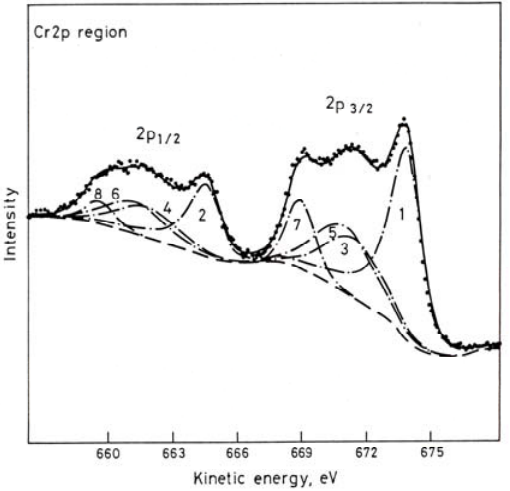
Figure 4. Mg K α -excited spectrum of the Cr 2p region of a specimen prepared by evaporating potassium dichromate onto a metallic chromium sheet. Doublet 1 + 2: Cr metal; doublet 3 + 4: Cr(III) oxide; doublet 5 + 6: Cr(III) hydroxide; doublet 7 + 8: potassium dichromate